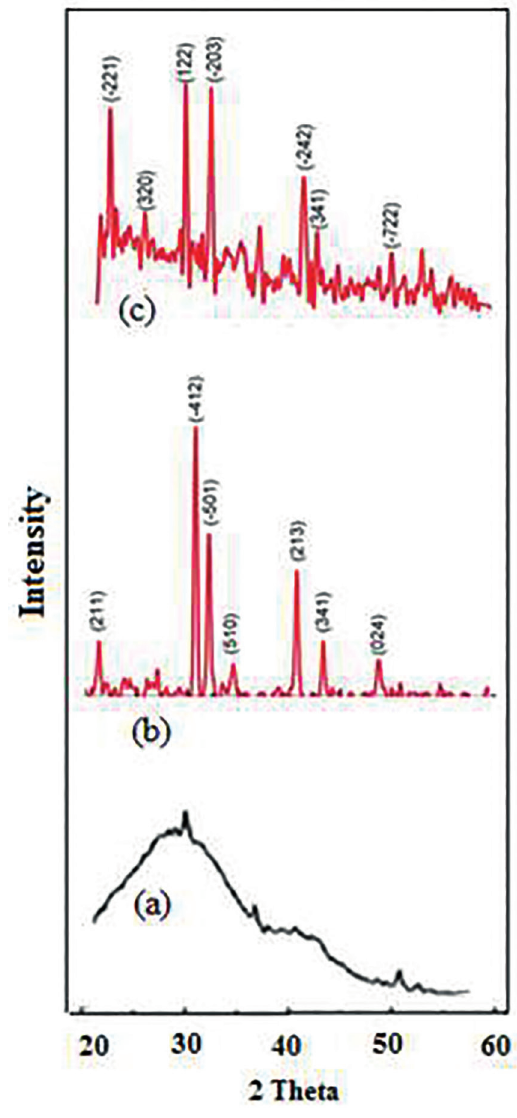
Figure 3: XRD of (a) PPY (b) nanophotoadduct (c) nanocomposite. = 106.3) obtained after refinement shows monoclinic structure of nanophotoadduct. The lattice parameters obtained for nanocomposite after refinement are a = 13.96298, b = 10.36719, c = 8.339, α = γ = 89.5 and β